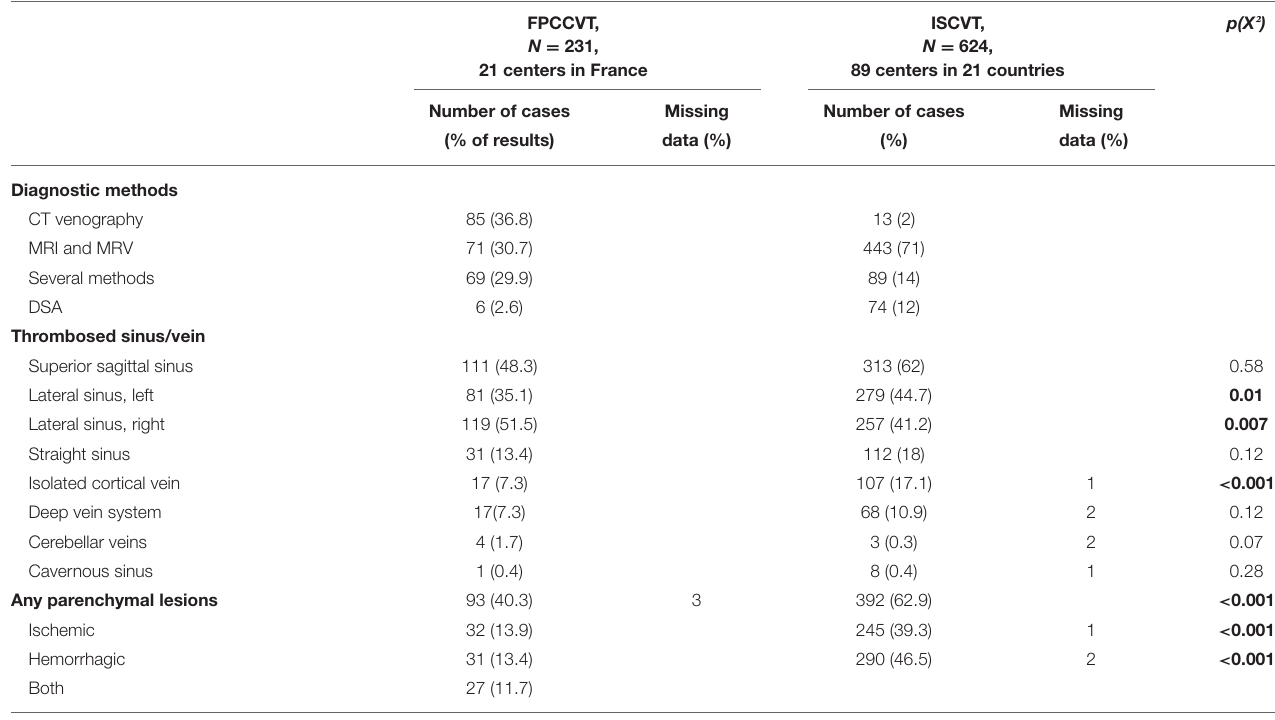
TABLE 2 | Radiological characteristics of the FPCCVT and ISCVT cohorts at